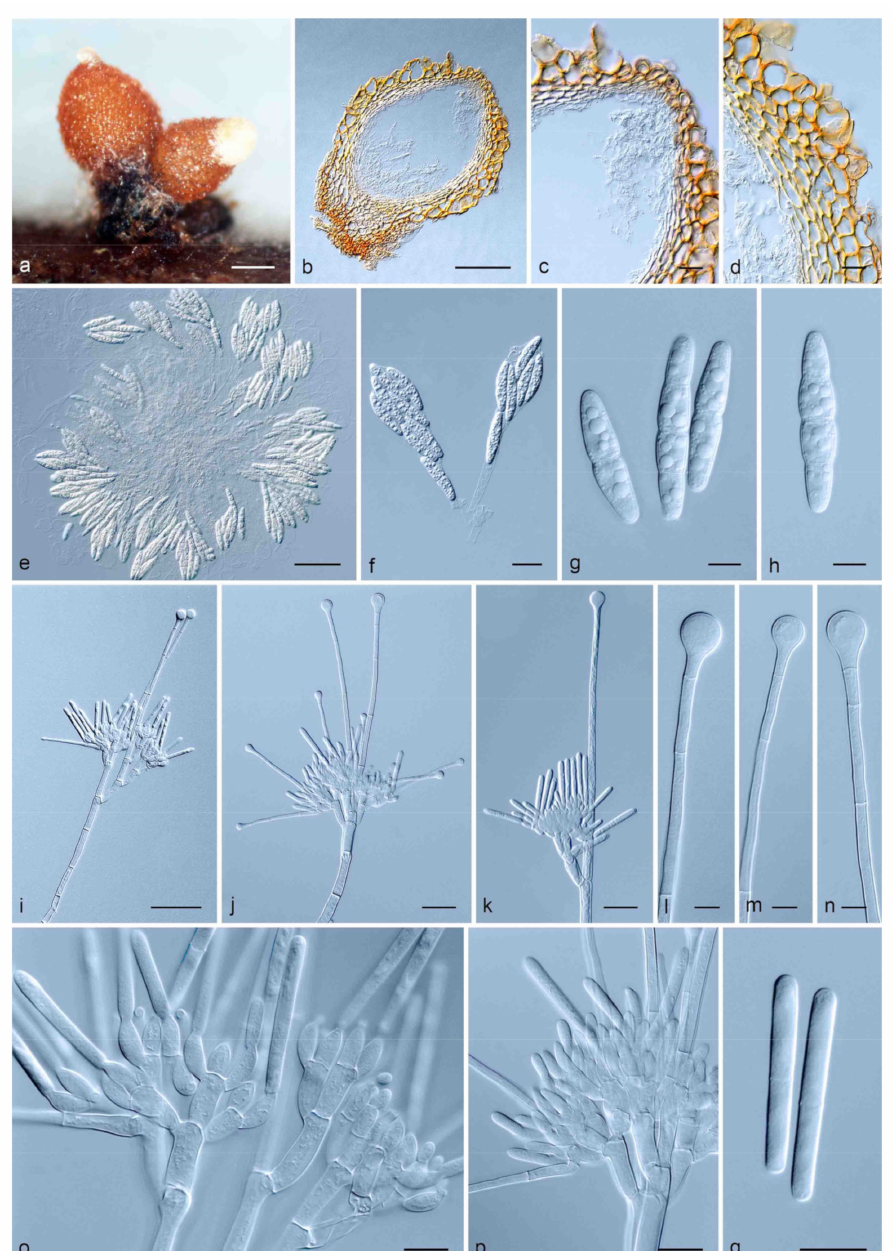
Figure A10. Calonectria kyotensis . ( a ). Perithecium; ( b ). vertical section through a perithecium; ( c ). cells around ostiolar region of perithecium; ( d ). section through lateral perithecial wall; ( e , f ). asci; ( g , h ). ascospores; ( i – k ). macroconidiophore; ( l – n ). sphaeropedunculate vesicles; ( o , p ). conid- iogenous apparatus with conidiophore branches and elongate doliiform to reniform phialides; ( q ). macroconidia.—Scale bars: a = 200 µ m; b = 100 µ m; c, d, f, j and k = 20 µ m; e and i = 50 µ m; g, h and o–q = 10 µ m; l–n = 5 µ